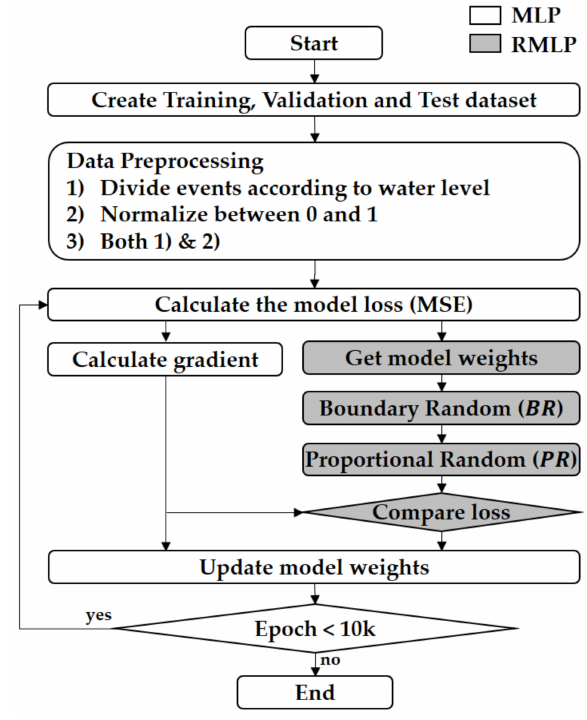
Figure 4. Learning process of the